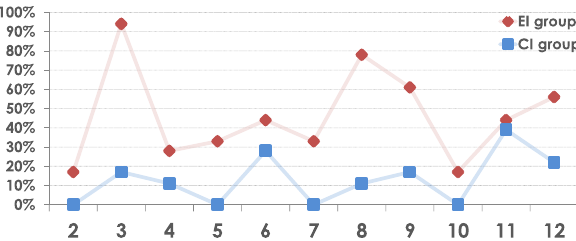
Figure 4. Frequencies of errors in each step of the Lego Duplo assembly task by participant groups.